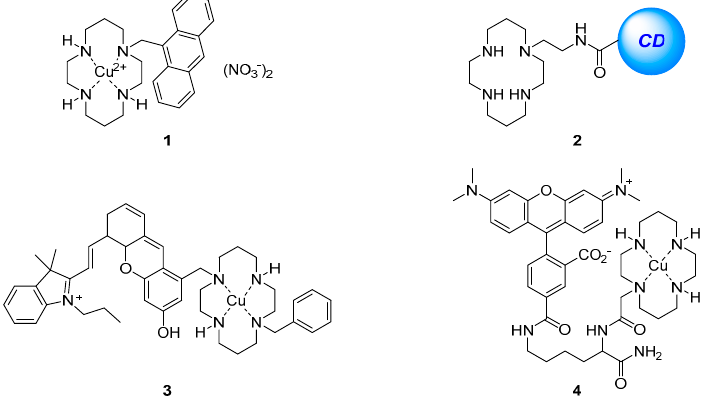
Figure 2. Cyclam-based fluorescent probes for sulfur anions and reactive nitroxyl species. The Cu 2+